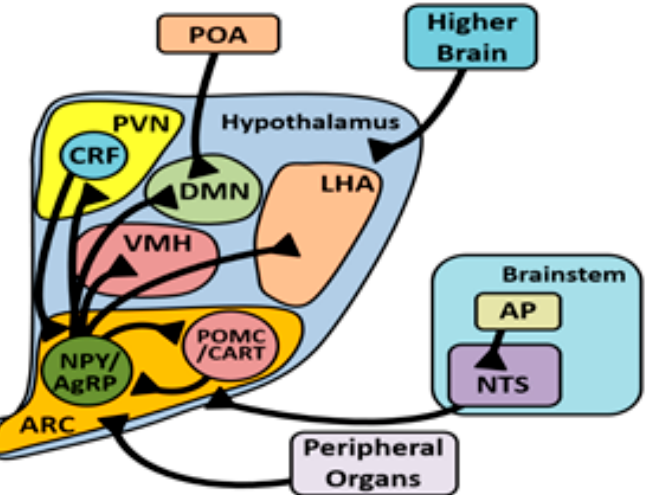
Figure 2. Based on mammalian models, there are projections of NPY neurons from the ARC to other appetite-associated hypothalamic nuclei, reciprocal innervation between NPY and POMC neurons in the ARC, and reciprocal innervation between NPY and CRF in the ARC and PVN, respectively. Peripheral signals influence feed intake by affecting the ARC. Several other inputs from higher brain centers and the brainstem also converge on the hypothalamus and affect appetite. Additionally, temperature-related information from the POA converges on the hypothalamus, although how this connection affects feed intake is unclear. Adapted from [64–66] .